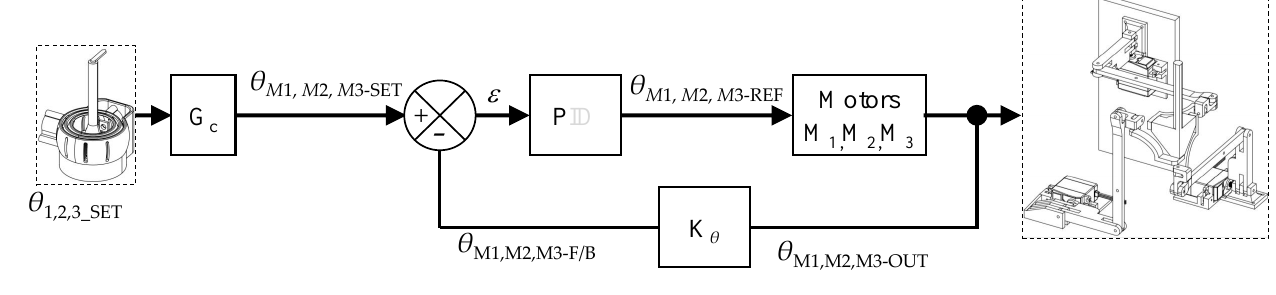
Figure 15. Block scheme of the